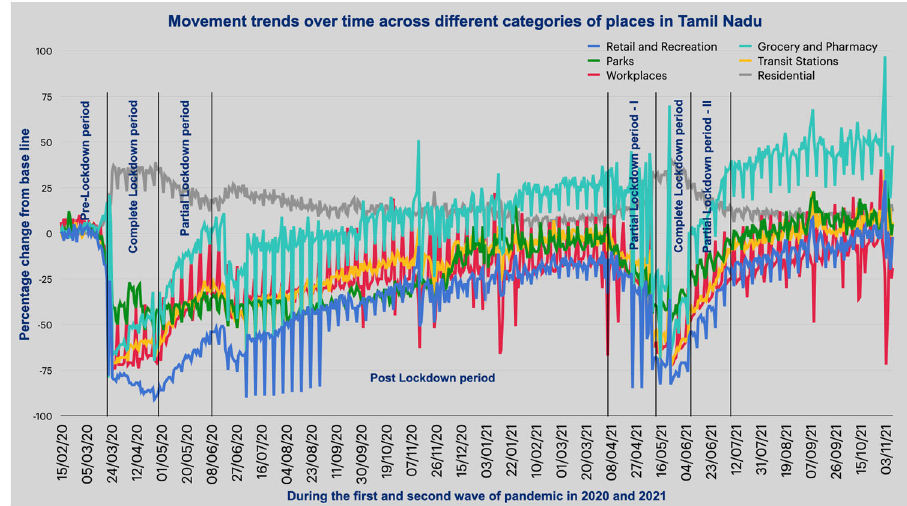
Fig. 6 Percentage changes in mobility from baseline — six spatial domains — Tamil Nadu — various phases — both waves. x -axis — dates various lockdown phases — Tamil Nadu — both waves in 2020 and 2021. y -axis: percentage change in mobility for six spatial domains from baseline. The vertical bars space out the different lockdown phases such as CL — complete lockdown, PL — partial lockdown and Post-L — post lockdown. Source: Google Community Mobility Reports.